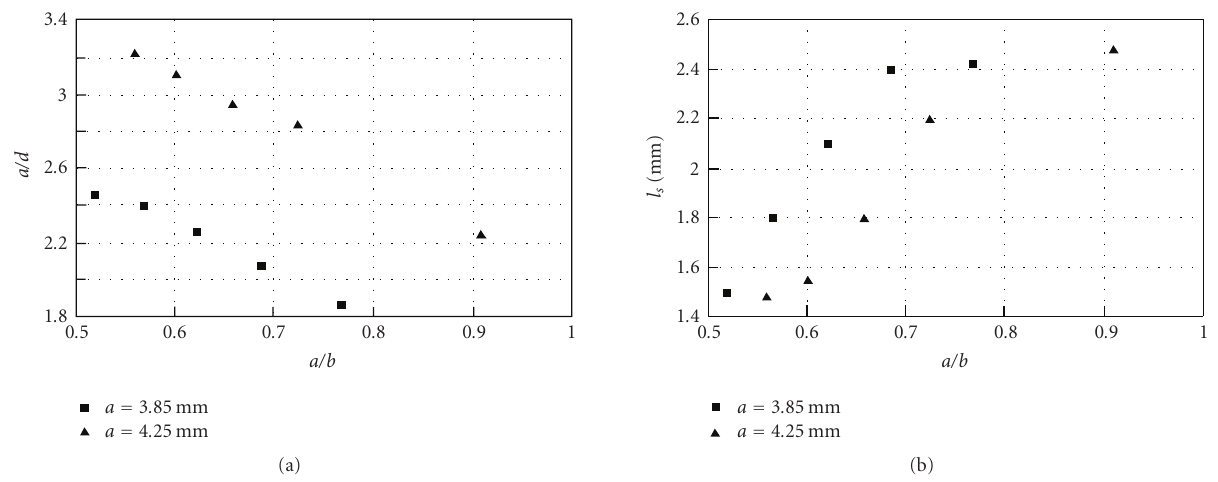
Figure 2: Length-to-width ratio (a) and open-circuit stub length (b) versus length-to-height ratio for a rectangular DRA operating in the mode at f 0 = 14 . 25 GHz. fundamental TE z 111